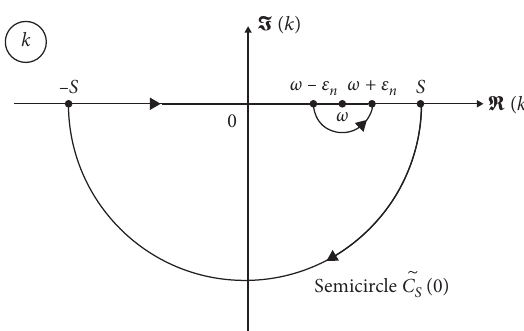
Figure 5: Closed contour in the lower half-plane for evaluation of 􏽥 I